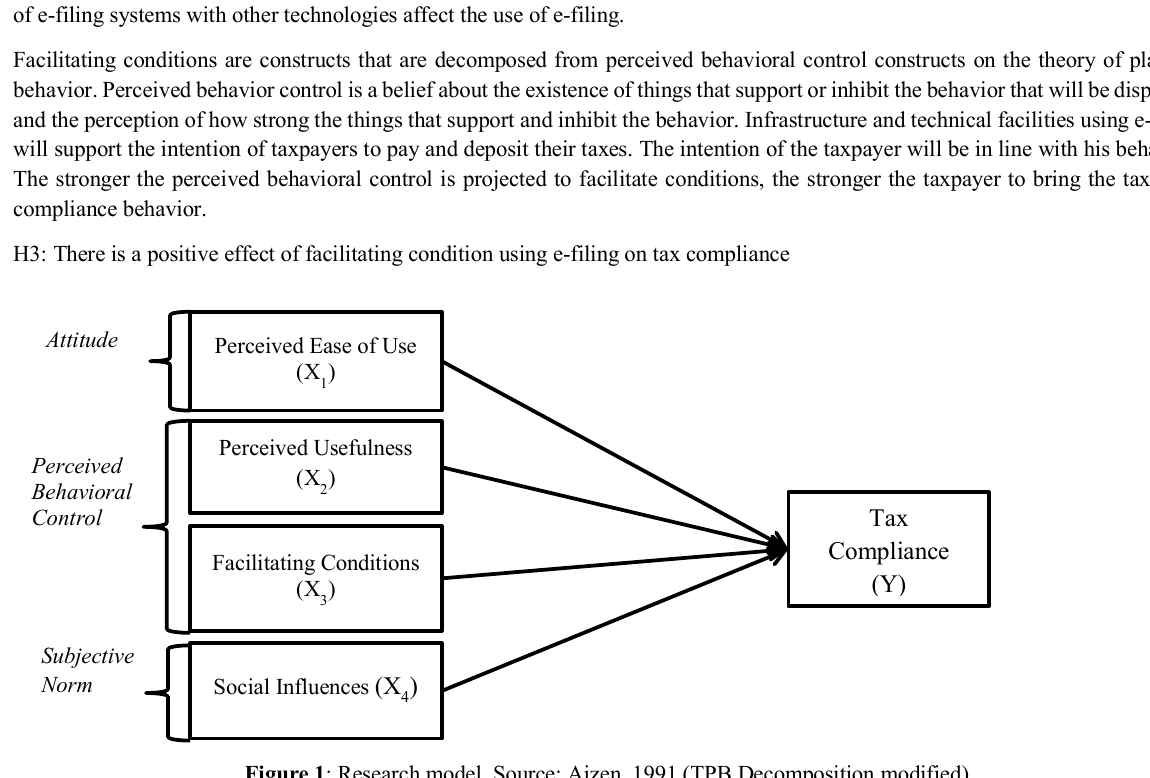
Figure 1 : Research model, Source: Ajzen, 1991 (TPB Decomposition